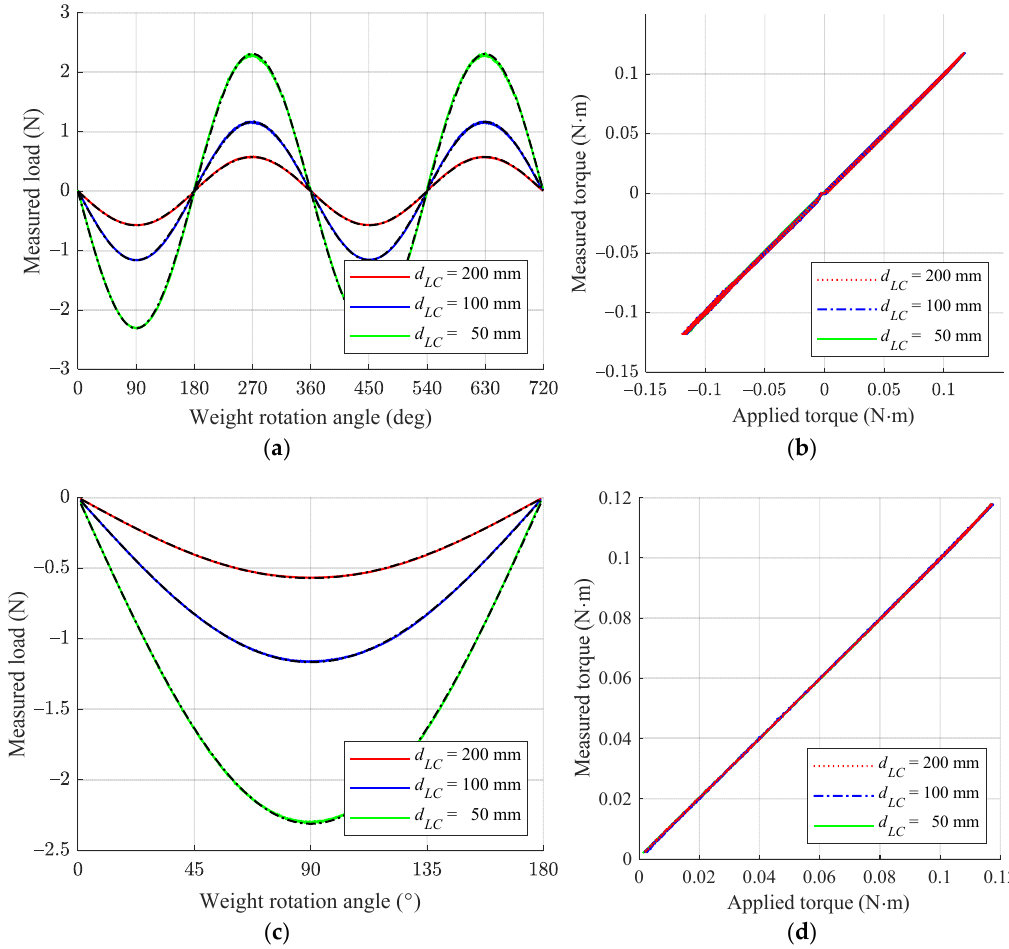
Figure 10. The measured load output by the sinusoidal torque input according to three different moment arm length of the load cell. Black dash-dotted lines represent fitted sine curves. The rotation angle range is ( a , b ) between 0° and 720°, and ( c , d ) between 1° and 179°.